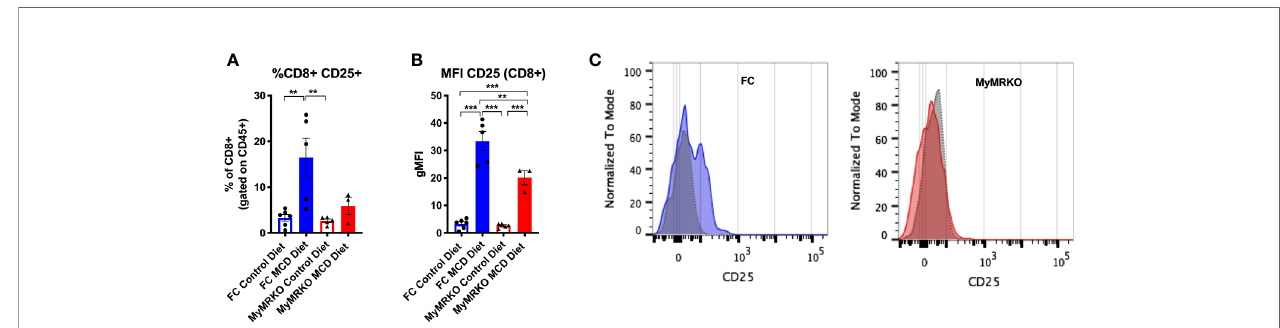
FIGURE 5 | Activation marker CD25 is highly expressed in CD8 + lymphocytes from fl oxed control (FC) mice. Flow cytometry was used to measure the percentage of CD8 + lymphocytes that expressed CD25 marker (A) and the global expression of CD25 in CD8 + lymphocytes or the gMFI (B) . A representative image of CD25 expression in myleoid mineralocorticoide receptor knockout (MyMRKO) and FC fed with chow diet (gray dotted histogram) or methionie and choline de fi cient diet (MCD) diet (colored histogram) is shown (C) . Statistical analysis was performed with one-way ANOVA comparing all treatments, with Tukey post-test. All fi gures display mean ± SEM. Statistical differences were considered signi fi cant according to **p < 0.01 ***p < 0.001.